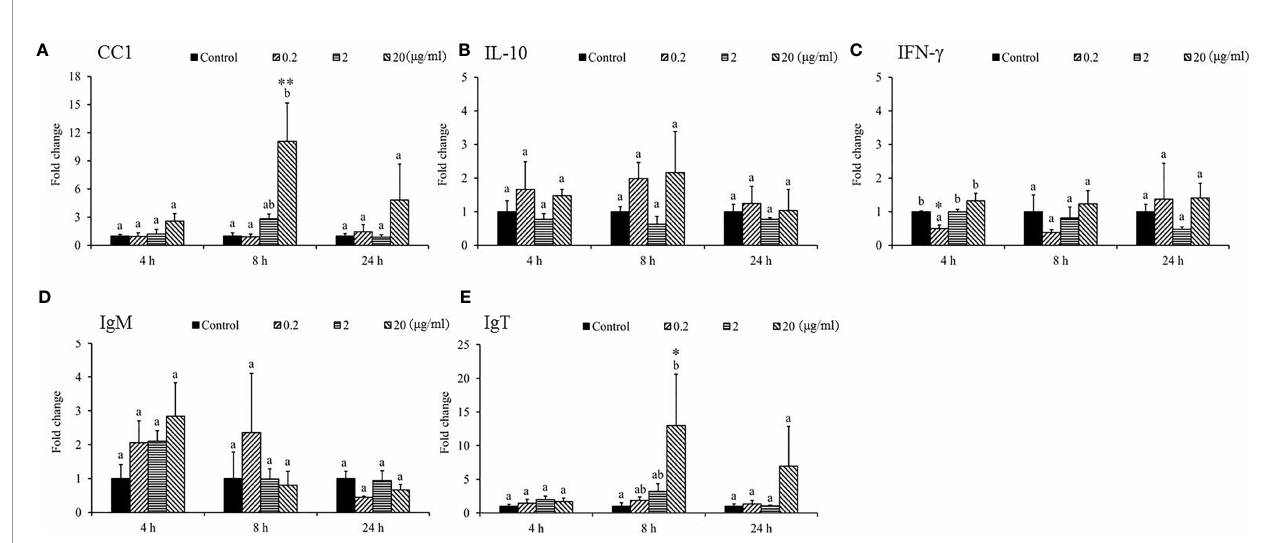
FIGURE 3 | Gene expression of immune genes in the head kidney (HK) tissue from Sarcodia suiae water extract (SSWE) treated cobia. HK samples were collected from fi sh injected with PBS (Control) or SSWE and the expression of (A) CC1 , (B) IL-10 , (C) IFN- g , (D) IgM , and (E) IgT was analyzed. The values are shown as mean + SEM (N = 3). Signi fi cant differences between samples and their time matched control group are shown with asterisks (* p < 0.05 and ** p < 0.01 ) and differences between groups are indicated by different